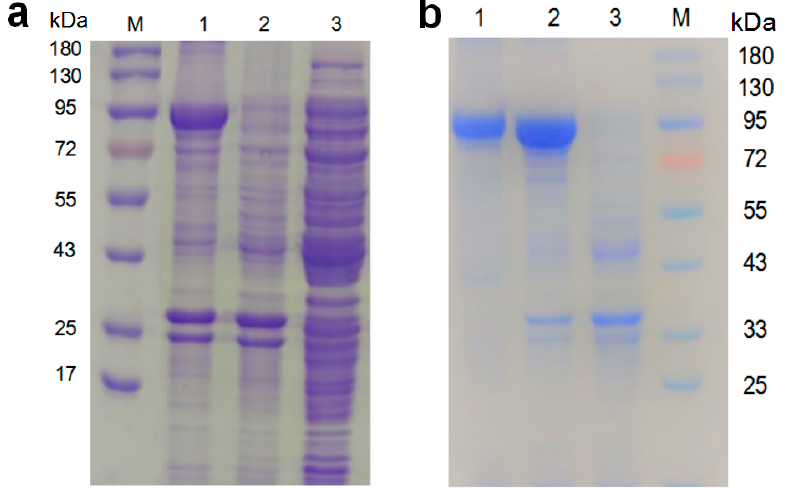
Figure 6. The expression and purification of the recombinant NiR analyzed by SDS-PAGE: ( a ) expres- sion of NiR-A2 by the recombinant bacteria. Lane M: molecular mass marker; Lane 1: precipitation of the broken recombinant bacteria (in the presence of IPTG) after centrifugation; Lane 2: precipitation of the broken recombinant bacteria (in the absence of IPTG) after centrifugation; Lane3: suspension of the broken BL21(DE3) harboring pET28a (+) after centrifugation; ( b ) purification of the recombinant NiR-A2. Lane M: molecular mass marker; Lane 1: purified recombinant NiR-A2; Lane 2: precipitation of the broken recombinant bacteria (in the presence of IPTG) after centrifugation; Lane3: precipitation of the broken BL21(DE3) harboring pET28a (+) after centrifugation.